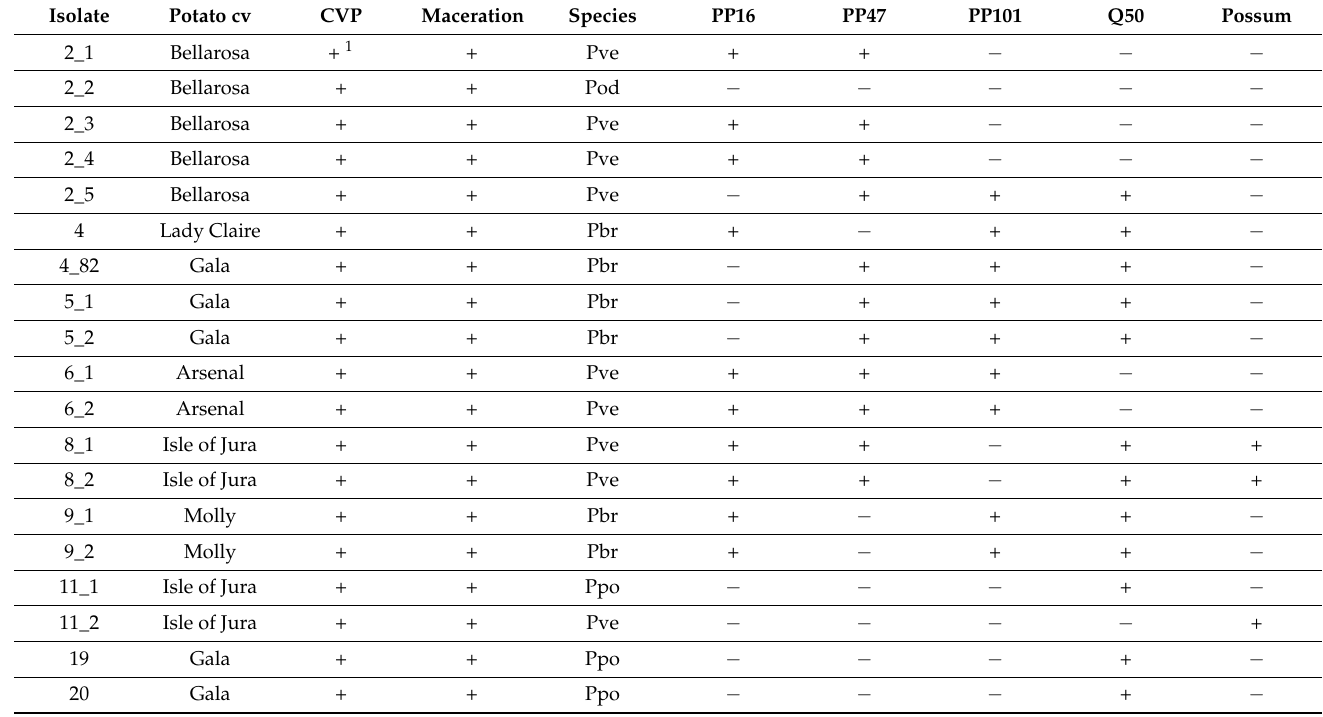
Table 1. Characteristics of bacteria causing soft rot of potato in agricultural season 2019 in Moscow region. Isolate Potato cv